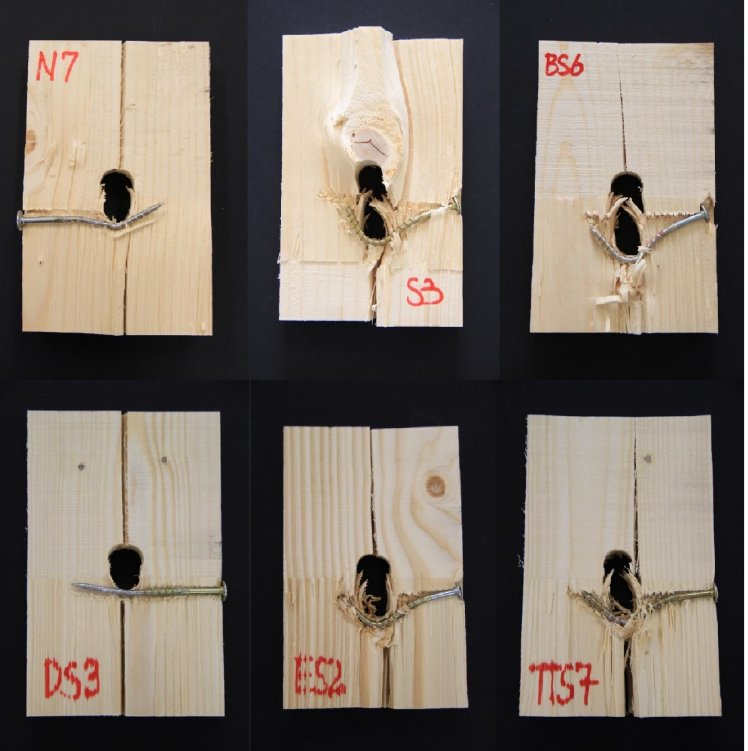
Figure 8. Specimens from each reinforced group after the embedment-strength test: high level of deformation of screw and embedment of screw head can be seen in groups S, BS, ES and TTS [31].